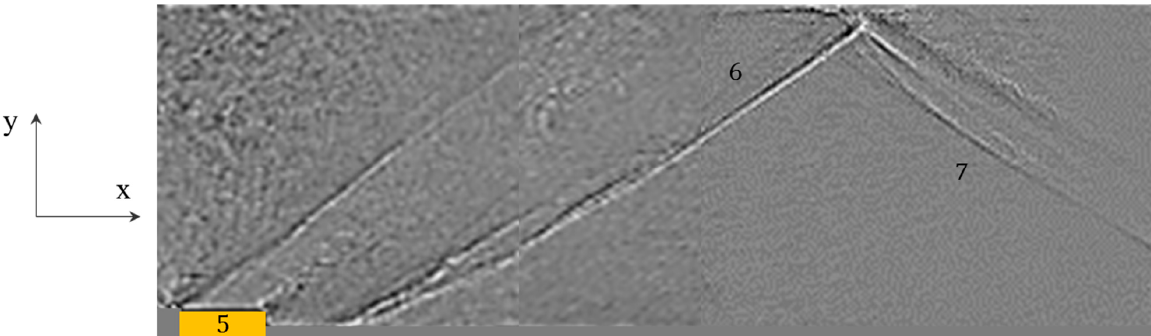
Figure 5. The shadowgraph image of quasi-stationary flow field 200 microseconds after the plane shock wave passed the obstacle. The Mach number of shock wave is 3.37; initial air density is 0.02 kg/m 3 . The zero-time corresponds to the moment of contact of the incoming shock wave with the obstacle (yellow rectangular). Designations (numbers) as in Figure